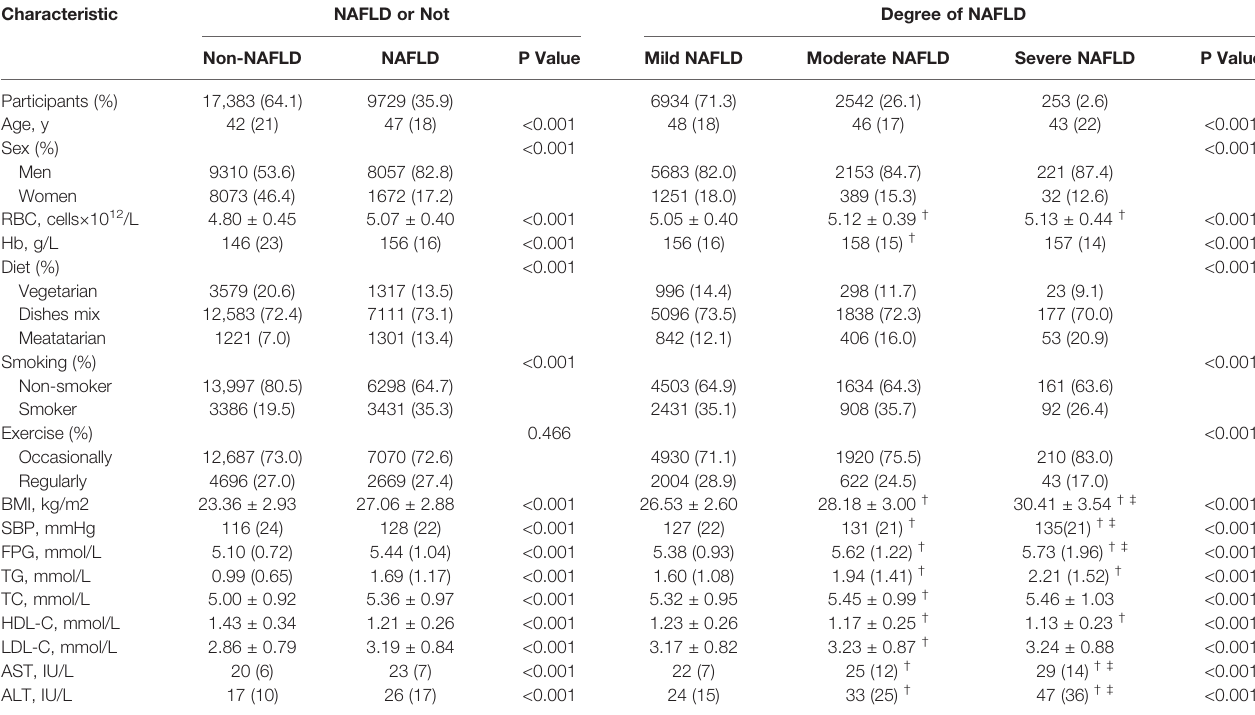
TABLE 1 | Baseline characteristics of study subjects based on NAFLD status.